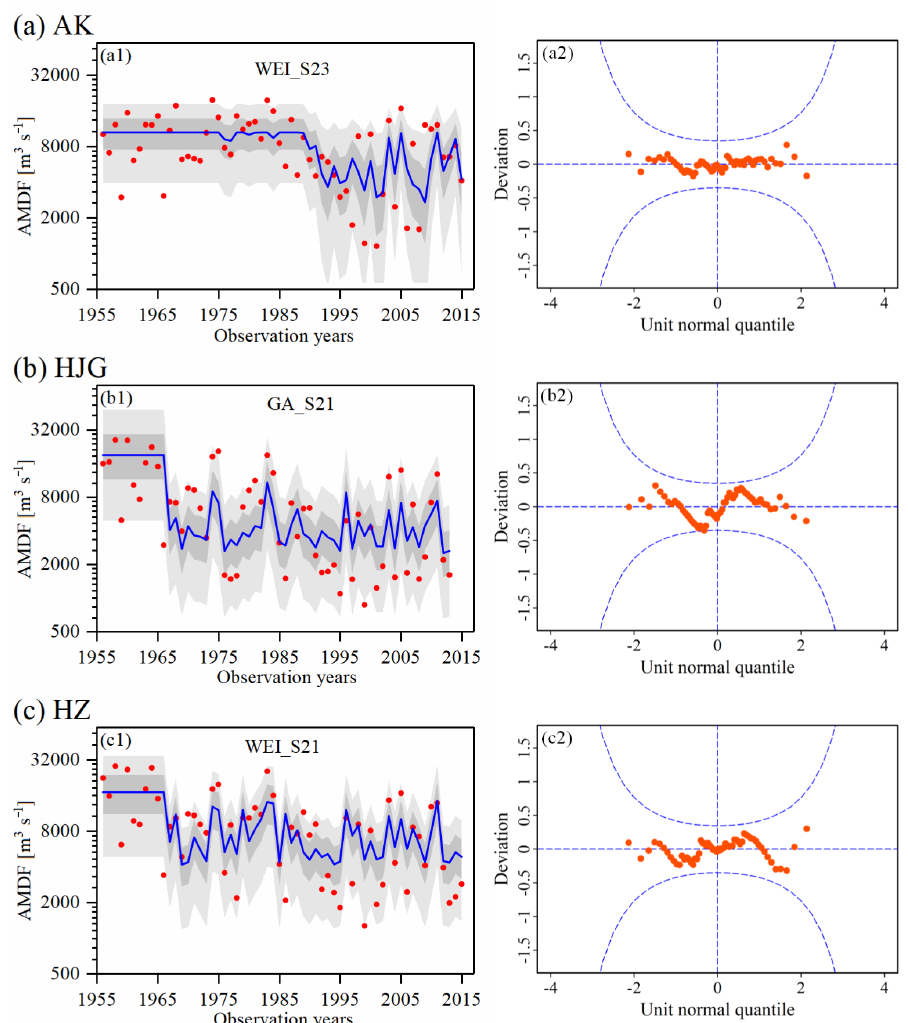
Figure 8. Performance of (a) WEI_S23 for the AK station, (b) GA_S21 for the HJG station, and (c) WEI_S21 for the HZ station. The left panels (a1, b1, c1) are the centile-curve plots in each station (the 50th centile curves are indicated by the thick blue lines, the light grey-filled areas are between the 5th and 95th centile curves, the dark grey-filled areas are between the 25th and 75th centile curves, and the filled red points indicate the observed series). The right panels (a2, b2, c2) are the worm plots. In a reasonable model, the plotted points should be within the 95% confidence intervals (between the two blue dashed